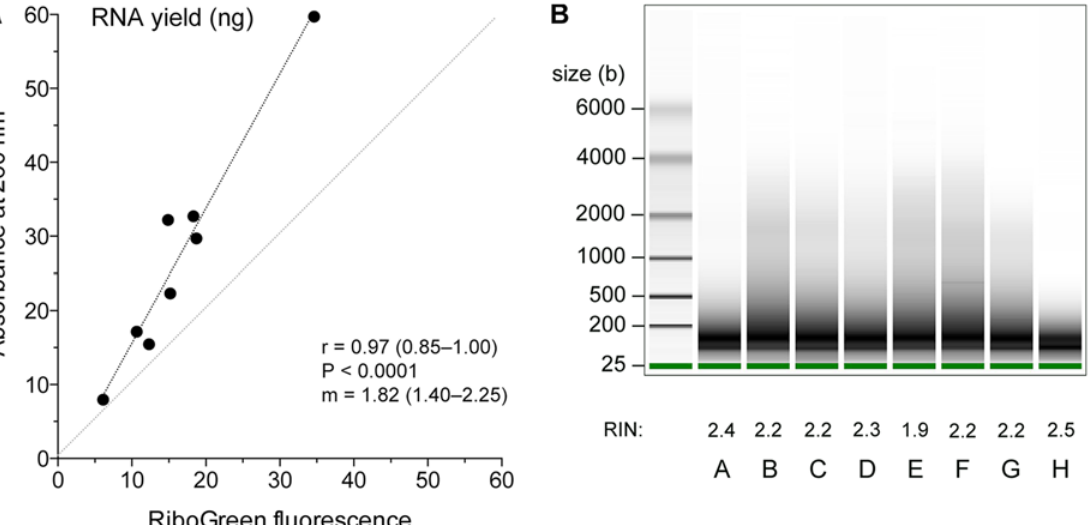
Fig 1. Assessment of total RNA extracted from FFPE tissues. A. Correlation between measurements of RNA yield ( μ g) obtained using absorbance at 260 nm or fluorescence with RiboGreen dye (n = 8). The lines of identity and linear regression (least squares method) and values and 95% confidence intervals of the Pearson coefficient ( r ) and slope of linear regression ( m ); P -values are also noted. B. Electrophoretogram of the 8 RNA samples ( A - H ). Samples were run on an Agilent Eukaryote Total RNA Pico chip on Bioanalyzer 2100. Sizes of molecular weight markers and the RNA integrity numbers are noted.